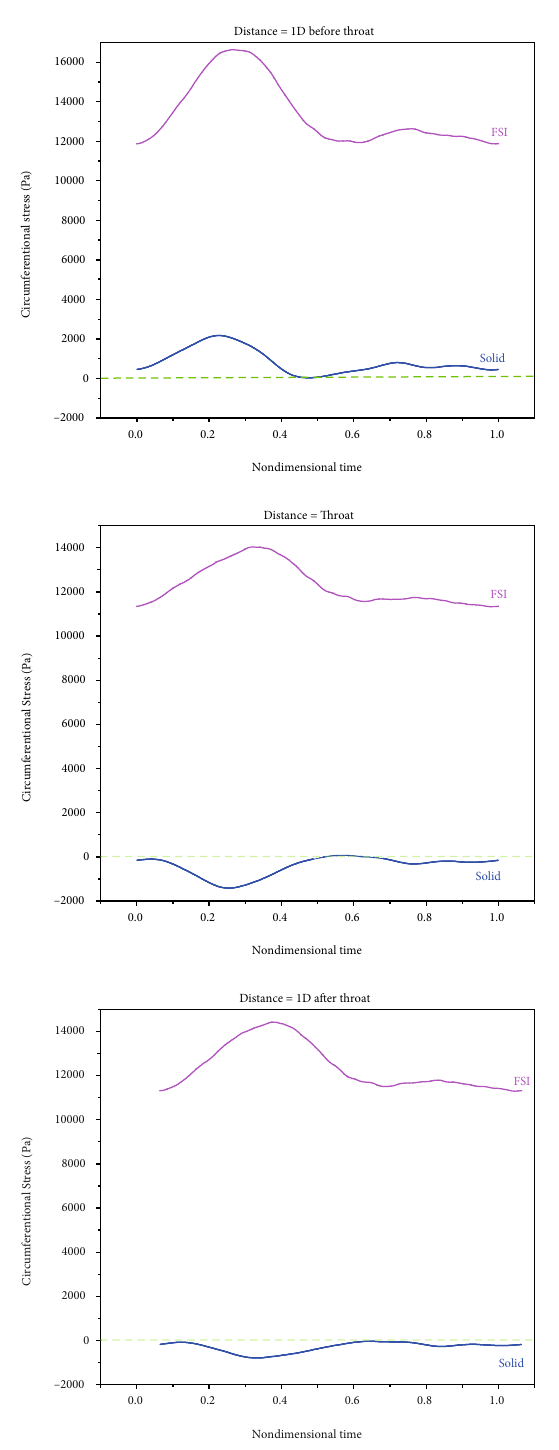
Figure 10: Comparing the circumferential stresses of the rigid and elastic walls in simple